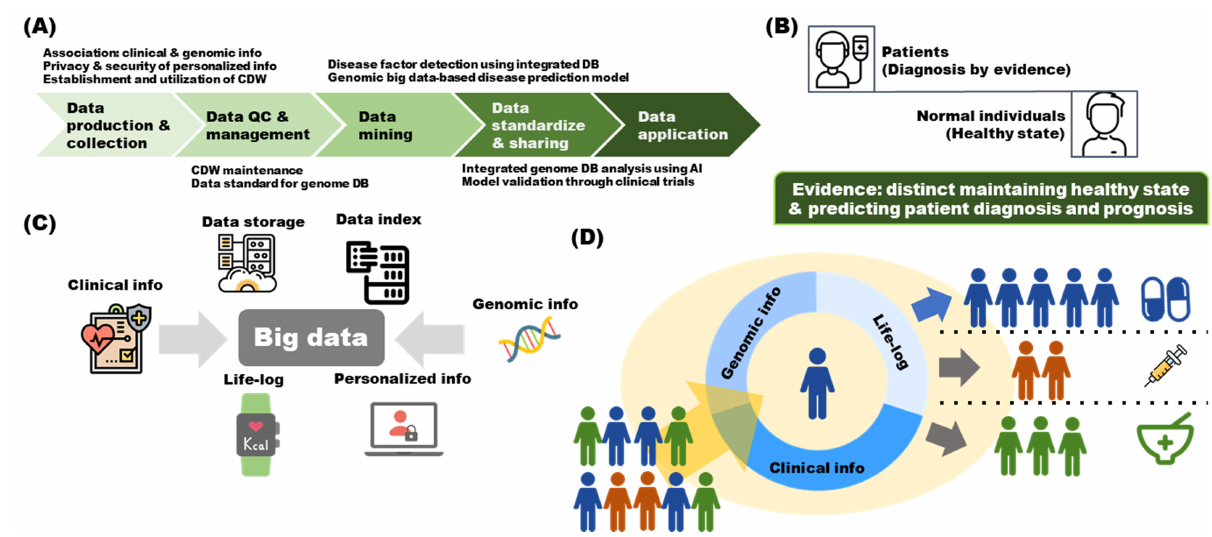
Figure 1. Overview of the genomic-information-based health management system. ( A ) The five processes required for the utilization of clinical and genomic information. ( B ) Clinical and genomic information should provide evidence to enable diagnosis or prognosis and to predict healthy status in normal individuals. ( C ) Along with clinical and genomic information, big data from various sources can be used for clinical decision-making through appropriate storage and indexing. ( D ) The final goal is to suggest an appropriate strategy for health management in healthy conditions and to provide customized treatment in diseased conditions, based on all data obtained for each individual. AI, artificial intelligence; CDM, common data model; CDW, clinical data warehouse; DB, database; info, information; QC, quality control.